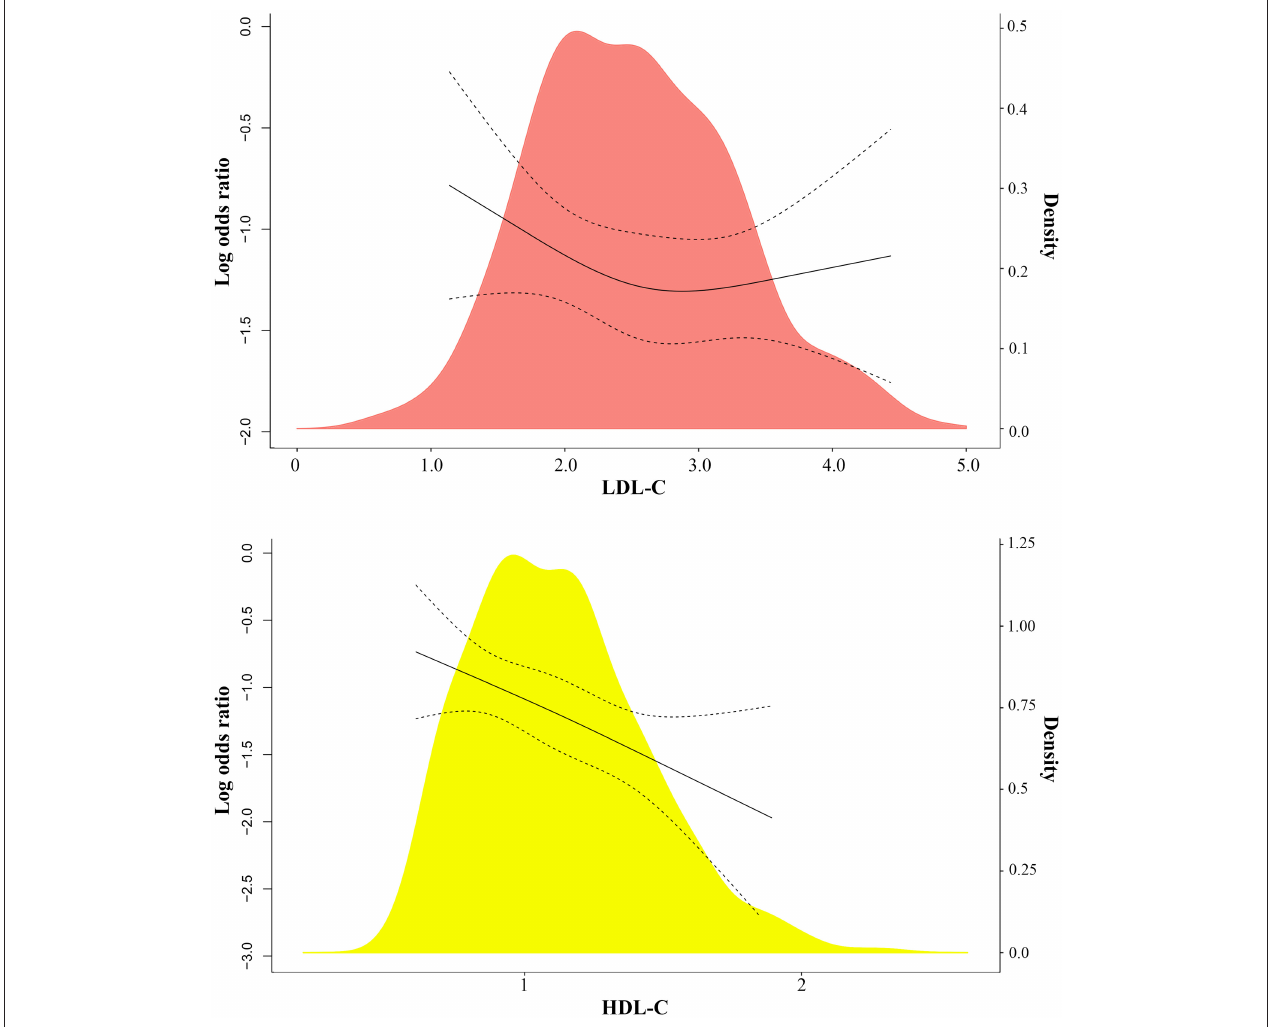
FIGURE 2 | Association between LDL-C, HDL-C, and severe COVID-19 using restricted cubic splines. (A) LDL-C and HDL-C on a continuous scale and risk of severe COVID-19 in 601 patients with SARS-CoV-2. Analyses were conducted using restricted cubic splines. The red and yellow areas indicate the distribution of LDL-C and HDL-C,